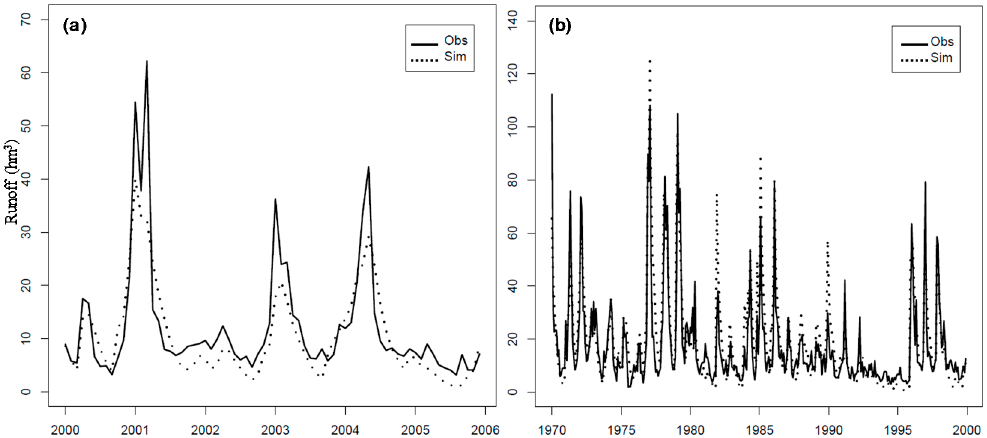
Figure 3. Observed and simulated runoff (hm 3 ) for the Fuensanta Basin: ( a ) calibration phase for the 2000–2005 period; and ( b ) validation phase for the 1970–1999 period.